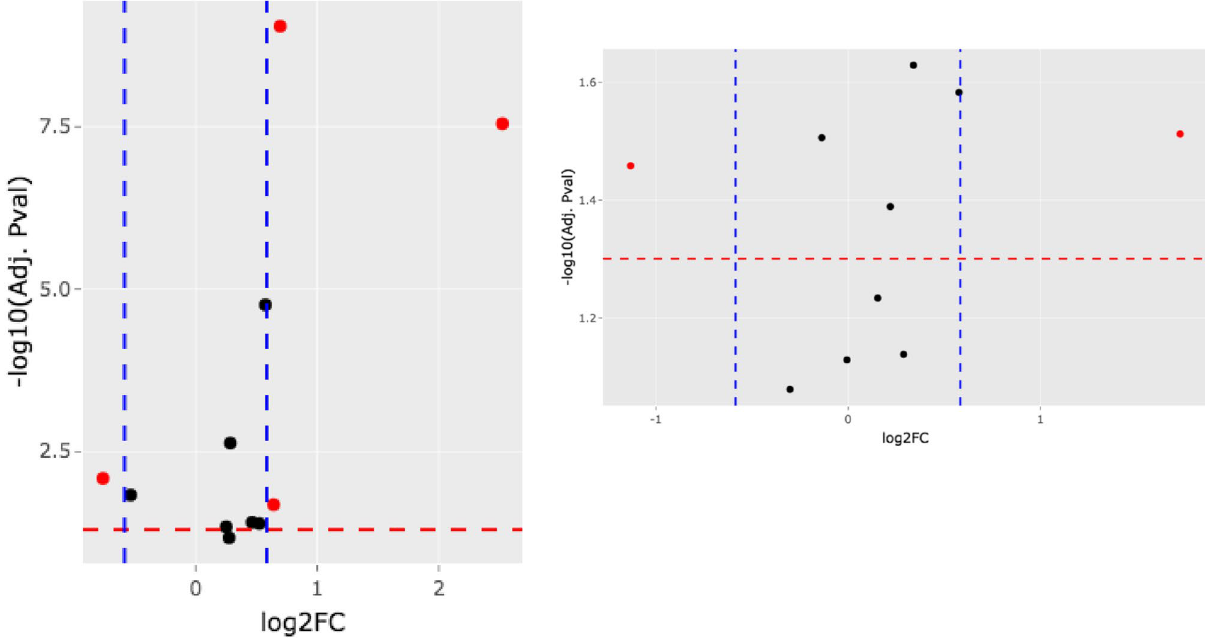
Figure 3. Volcano plot of the TMPRSS2 and ACE2 genes. ( A ) Volcano plot showing on the x-axis the log2 fold change and the y-axis the significance (− log10 of the Benjamini-corrected p-value) across different DS transcriptomic studies detecting TMPRSS2 . Red dots indicate contrasts with deregulation > 1.5 of absolute fold change (dashed blue lines) and < 0.05 adjusted p-value (dashed red line). ( B ) Same as in ( A ) but for ACE2